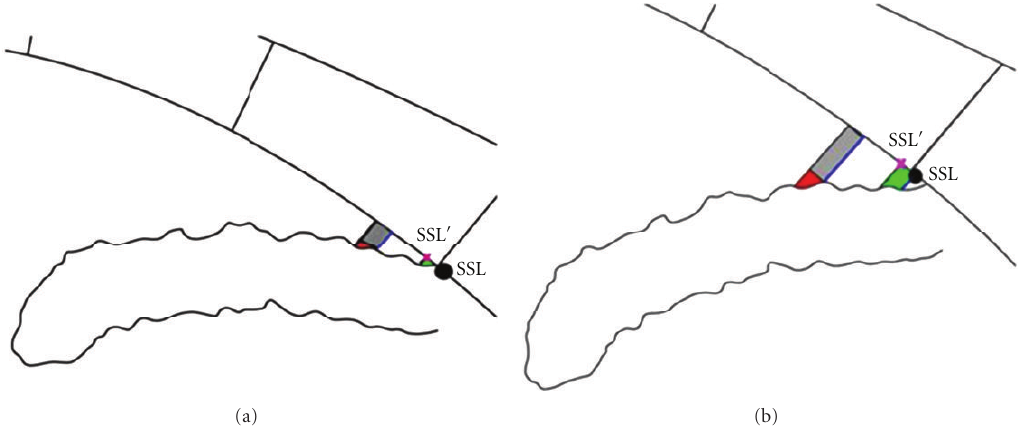
Figure 2: E ff ect of scleral spur landmark (SSL) location on TISA750 and AOD750. Illustrations show the impact of SSL location on trabecular-iris space area at 750 μ m (TISA750) and angle opening distance at 750 μ m (AOD750) calculations for nonopen-angle eyes (a) and open-angle eyes (b). If the SSL location is moved by h to SSL (cid:2) location, TISA750, now based on SSL (cid:2) , gains the grey area and red area and loses the green area. Both the green area and red area are small relative to the grey area, especially in nonopen-angle eyes (a). In addition, the di ff erence between the green and red areas are negligible (gain red and lose green). Thus, when SSL is moved to SSL (cid:2) , TISA750 is changed by h × AOD750 based on SSL (longer blue line). The SSL location’s impact on AOD750 is dependent on angle width and iris shape (the length of the anterior border of red area). The AOD750 changes are smaller if the angle is nonopen and the iris is